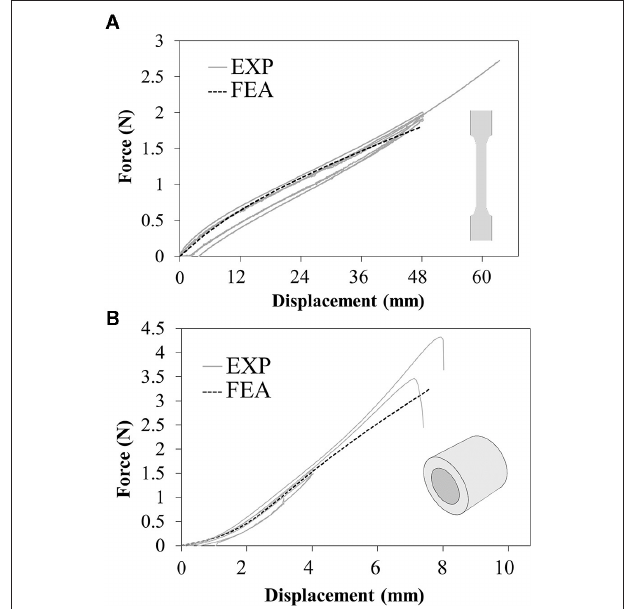
FIGURE 4 | Force-displacement plots resulting from experimental tests (solid lines) and numerical simulations (dashed lines) of the (A) uniaxial tensile tests on dog-bone samples and (B) annular tensile tests on ring